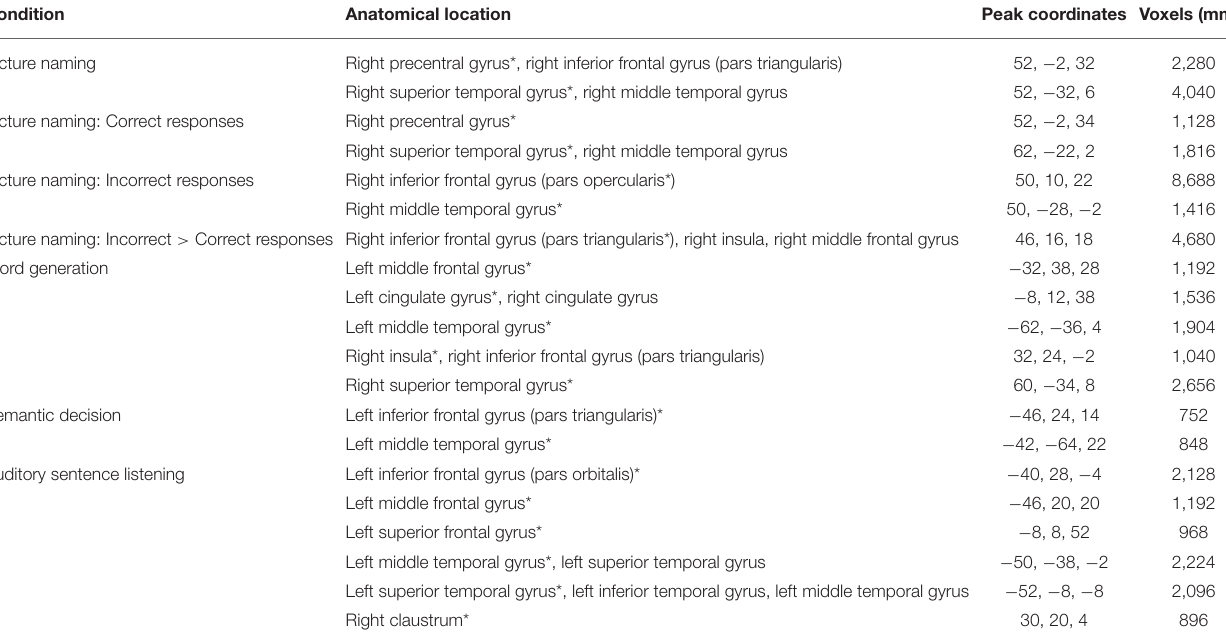
TABLE 4 | Anatomical locations of peak coordinates and cluster size for each single task ALE in PWA.